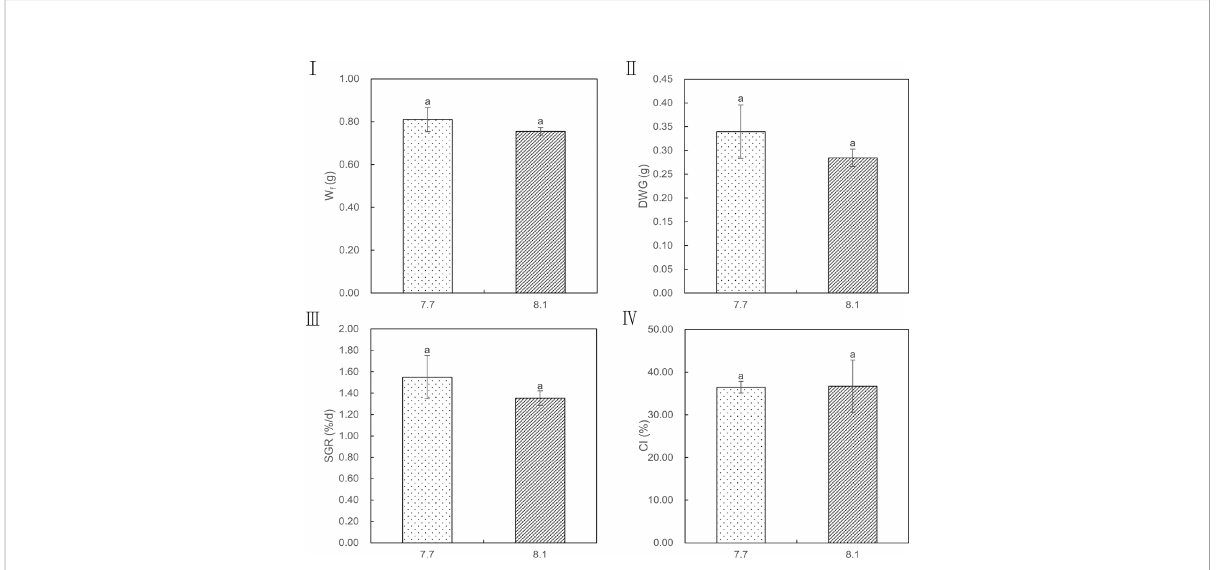
FIGURE 2 W f , DWG, SGR, and CI values of razor clam cultured under pH 7.7 and pH 8.1 exposure over the 35-day experiment. W f (I): fi nial dry body weight, DWG (II): fi nial dry body weight gain, SGR (III): speci fi c growth rate, CI (IV): condition index. Different lowercase letters indicate signi fi cant differences (P<0.05) between the two groups.